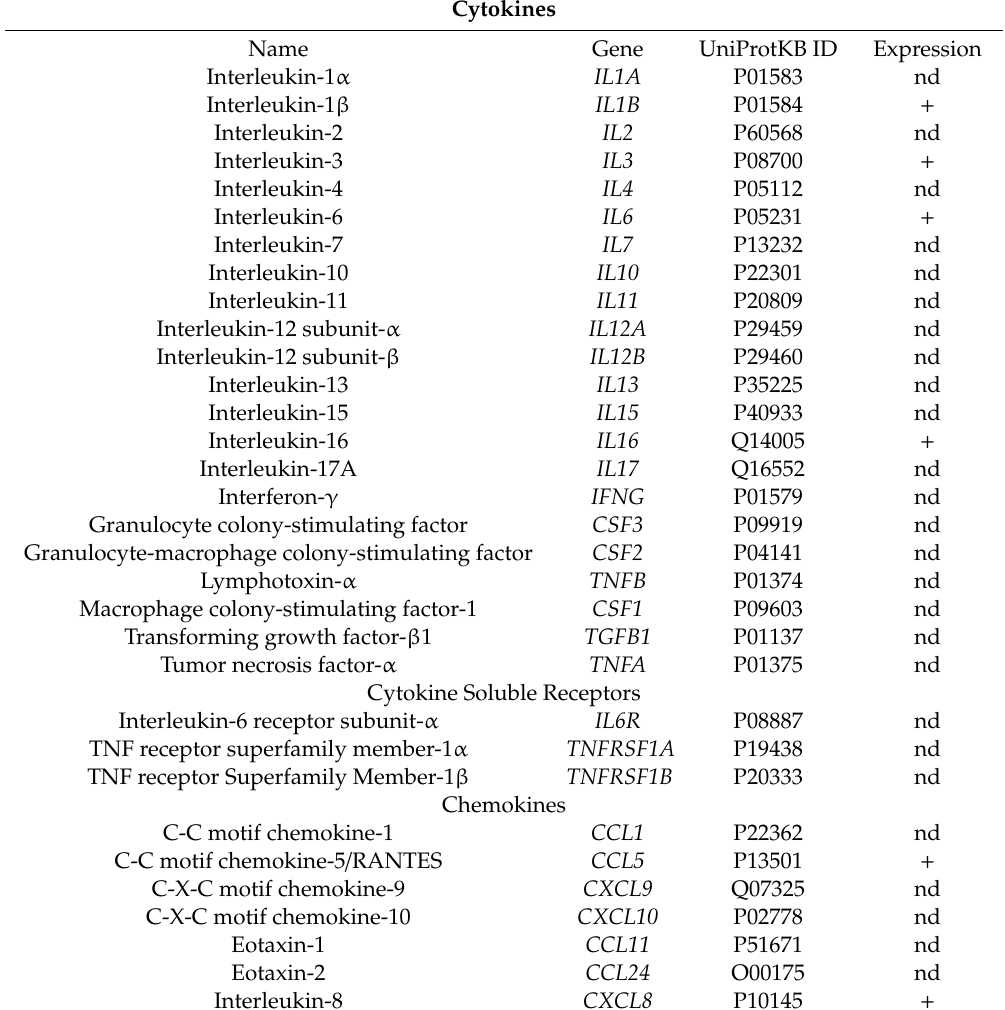
Table 1. Proinflammatory agents analyzed via antibody array in conditioned media of untreated NAHAs. Cytokines Name Gene UniProtKB ID Expression Interleukin-1